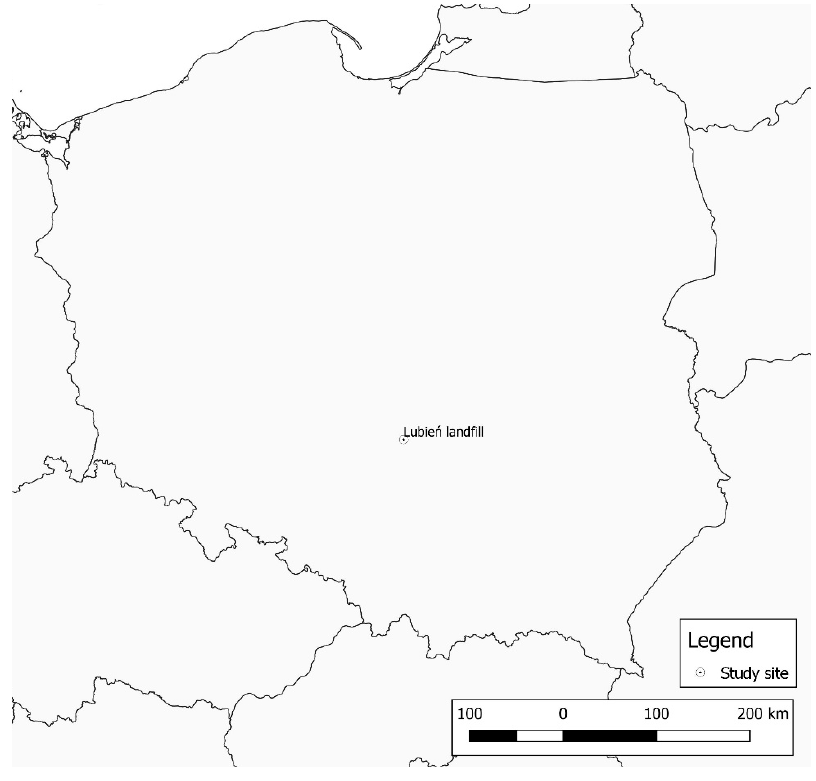
Figure 1. Location of the study site.